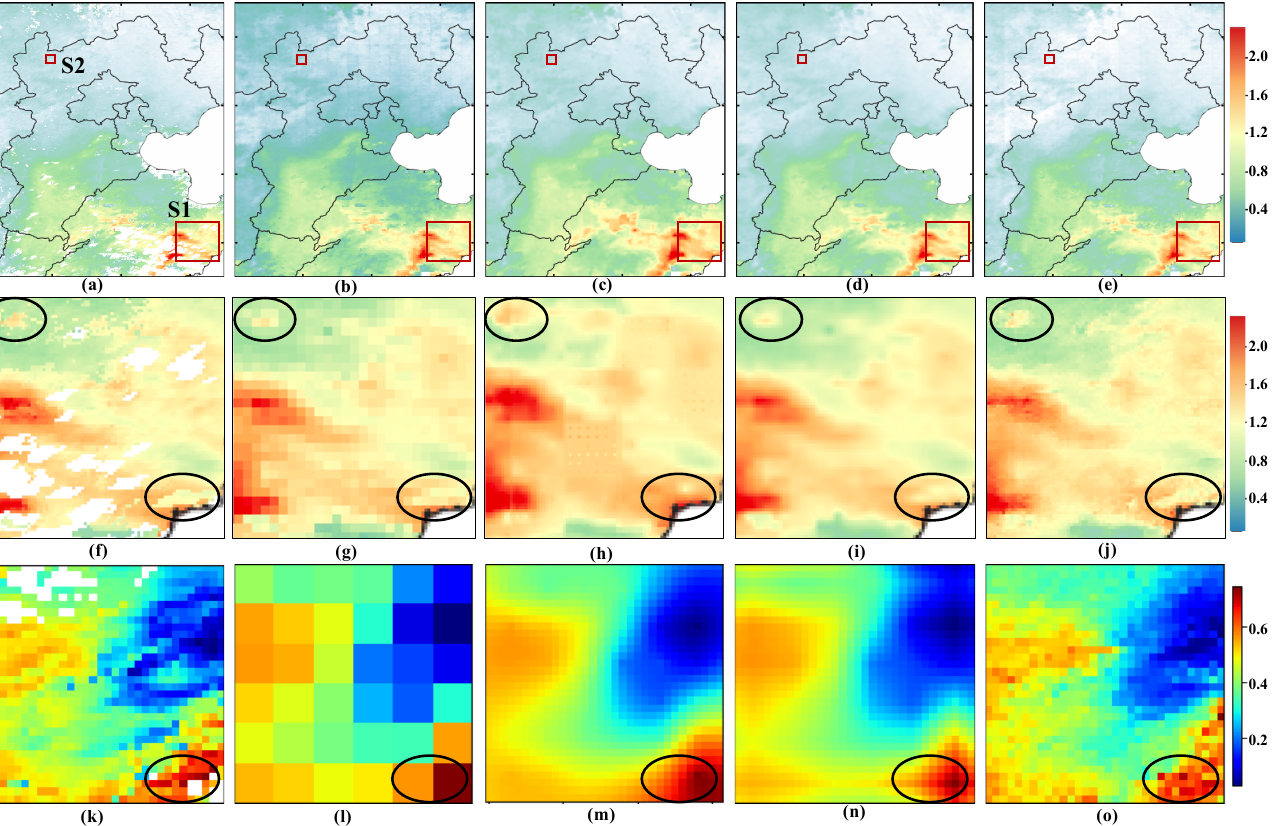
Figure 4. The spatial distribution performance of different method estimations with MAIAC AOD (1 June 2017). ( a ) original MAIAC AOD 1 km; ( b ) down-sampled MAIAC AOD 5 km; ( c ) Kriging estimates AOD 1 km; ( d ) SRCNN estimates AOD 1 km; ( e ) AeroCGAN estimates AOD 1 km; ( a – e ) are overall spatial distribution; ( f – j ) are the detailed comparison of big rectangular area S2; and ( k – o ) are the detailed comparison of small rectangular area S1. Some obvious details are marked by the ellipses